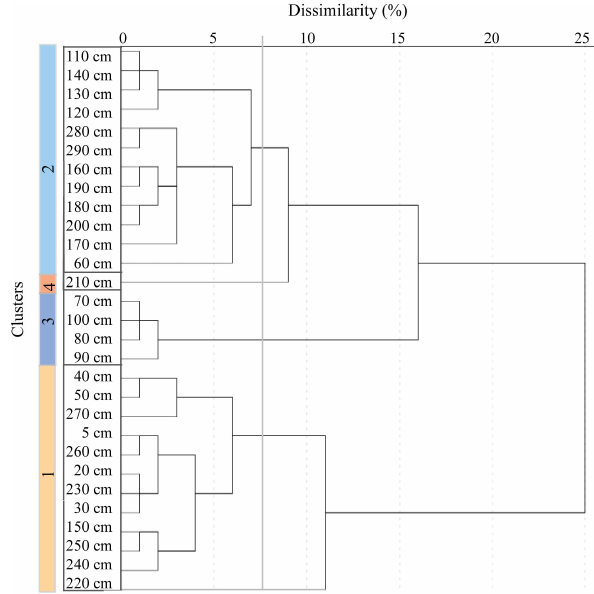
Figure 4. Hierarchical cluster analysis dendrogram illustrating ag- glomeration of four clusters at dissimilarity of